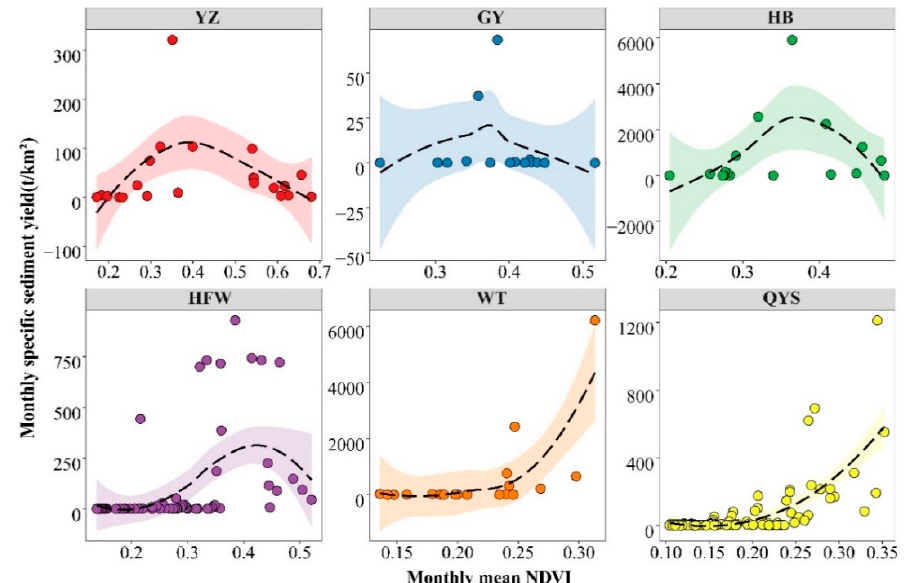
Figure 10. Relationships between monthly specific sediment yield and the NDVI.